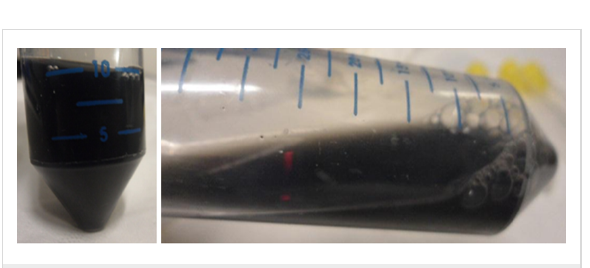
Figure 5: MWCNT/ferrocene mixture after adding SDS surfactant.